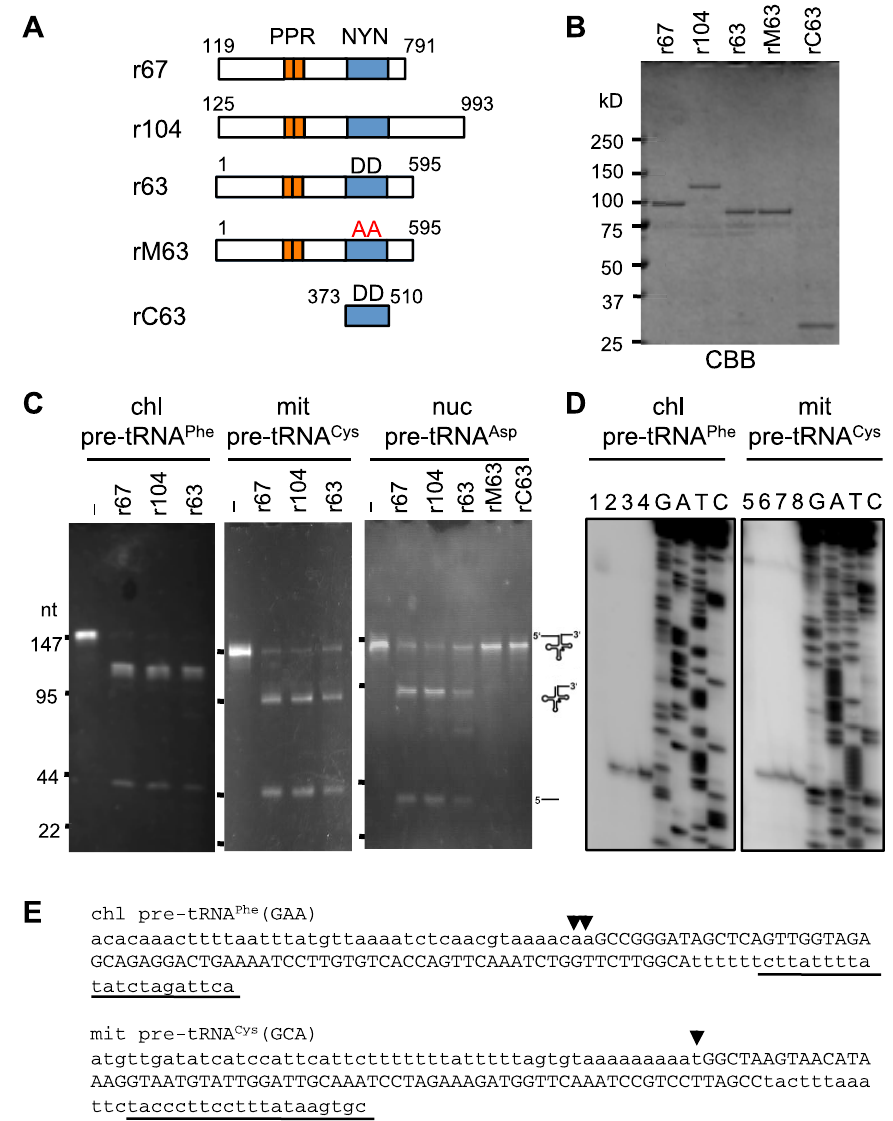
Figure 3. Pre-tRNA cleavage assay of P.patens PRORP-like proteins. ( A ) Schematic diagrams of various recombinant proteins. Recombinant proteins r67, r104, r63, and rM63 indicate, respectively, PpPPR_67, PpPPR_104, PpPPR_63, and the mutant PpPPR_63, the two catalytic aspartates (DD) of which were substituted with alanines (AA). rC63 consists of the tag sequences and an NYN domain only of PpPPR_63. ( B ) Coomassie brilliant blue (CBB)-stained recombinant proteins (1 m g each). ( C ) RNase P activity was assayed by using 2 m g of in vitro -transcribed chloroplast (chl) pre- tRNA Phe , mitochondrial (mit) pre-tRNA Cys , or nuclear (nuc) pre-tRNA Asp and 100 ng of recombinant proteins. The reaction products were separated by using 8% denaturing PAGE and stained with ethidium bromide. ( D ) The 5 9 -ends of processed pre-tRNAs in (C) were determined by primer extension analysis. Processed pre-tRNAs without proteins (lanes 1 and 5), with r67 (lanes 2 and 6), with r104 (lanes 3 and 7), or with r63 (lanes 4 and 8) were reverse transcribed from the 5 9 -end-labeled primers underlined in (E). ( E ) The nucleotide sequences of chloroplast (chl) pre-tRNA Phe and mitochondrial (mit) pre-tRNA Cys are shown with small letters (5 9 leader and 3 9 trailer sequences) and capital letters (predicted mature tRNA). Arrowheads indicate the 5 9 -end positions determined in (D). Underlined sequences indicate the position of primers used for primer